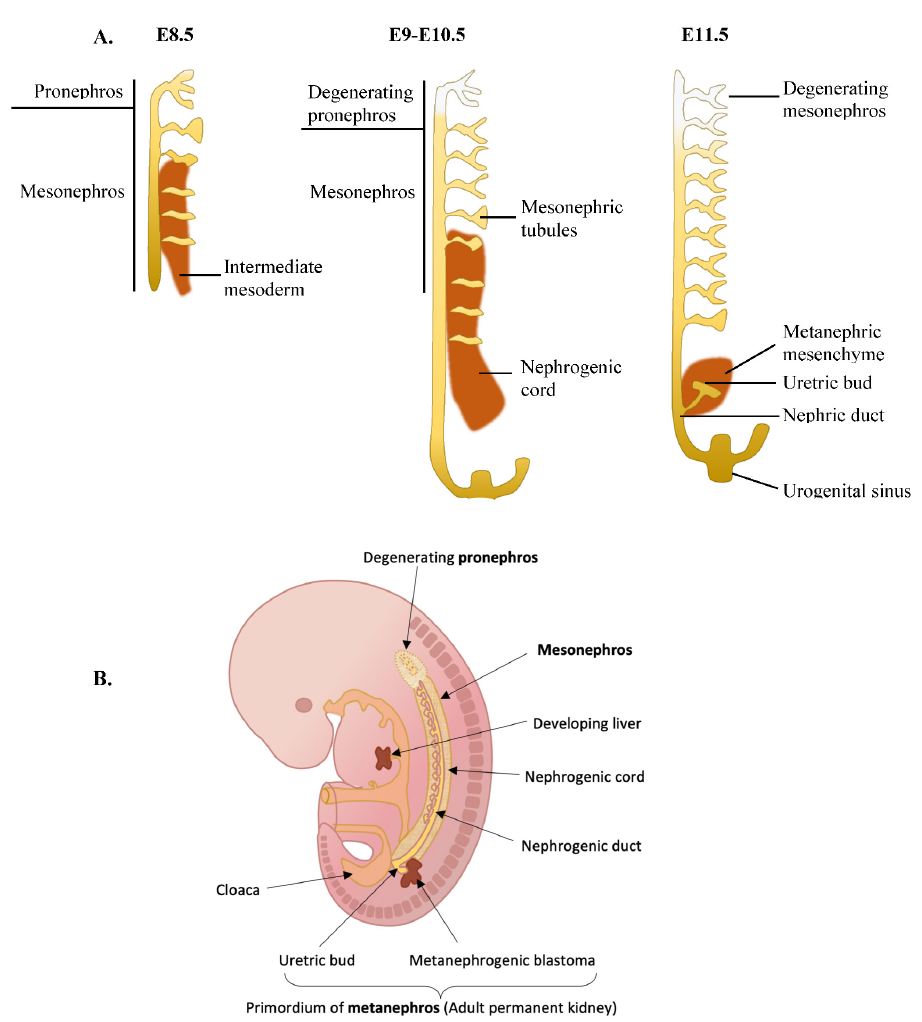
Figure 2. Illustration of embryonic kidney development in mice. ( A ) An illustration of the kidney development timeline in mice. ( B ) Mouse kidney development on E11 shown in the context of the whole mouse embryo [97].